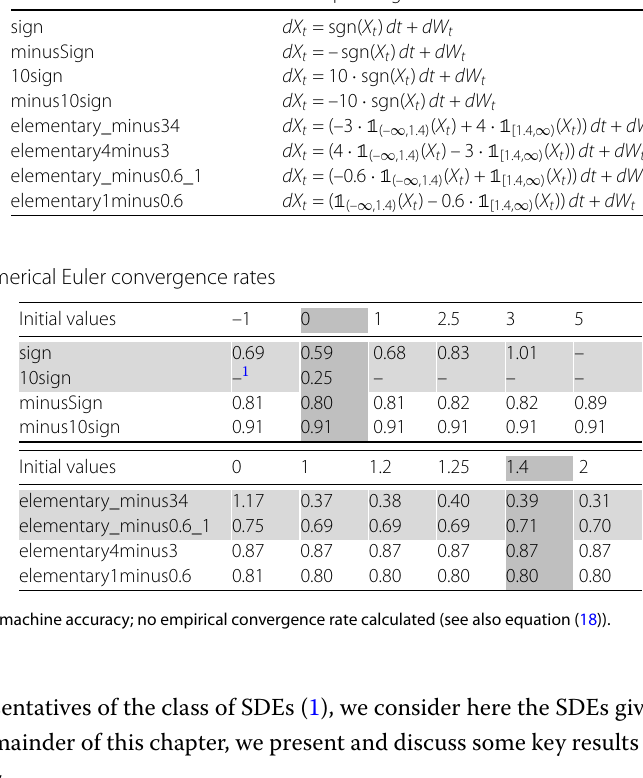
Table 1 Selection of analyzed SDEs Drift coefficient